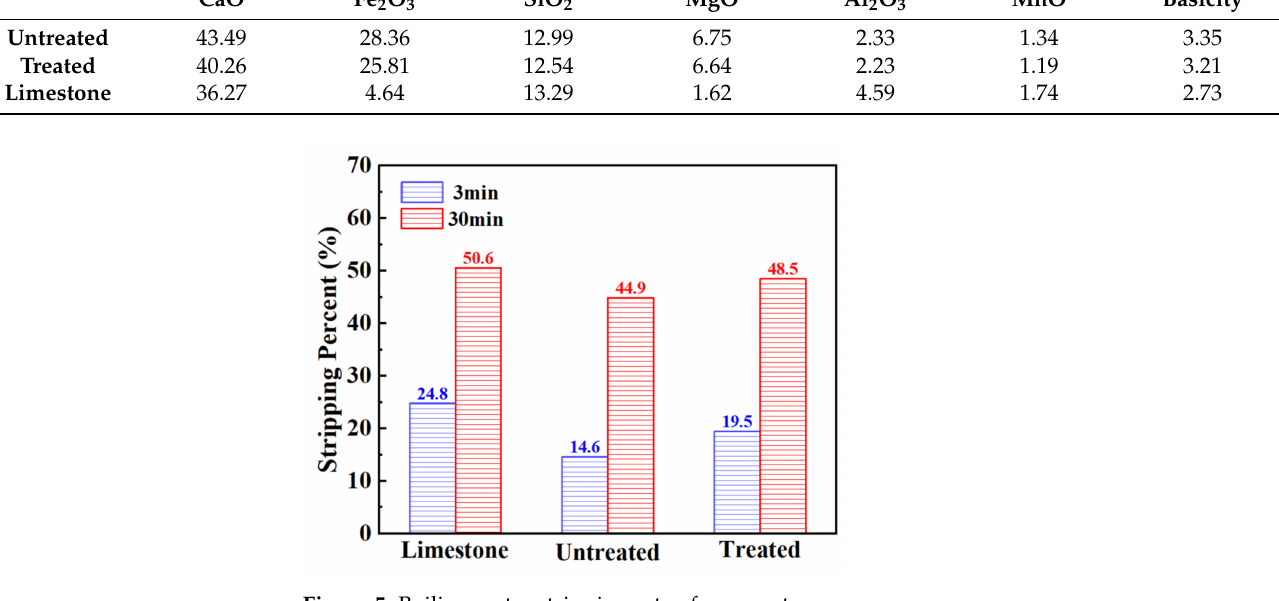
Figure 5. Boiling water stripping rate of